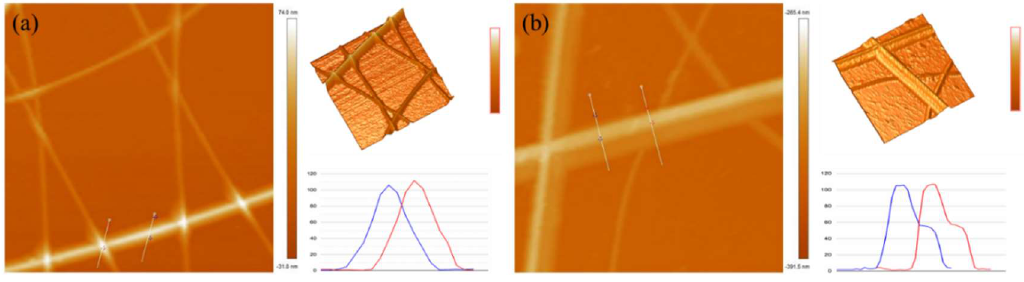
Figure 5. The atomic force microscope (AFM) images of ( a ) SLD‐AgNW films and ( b ) SLD‐AgNW/G films. The images at the upper right show the 3D AFM images, and the images at the bottom right show the height contrast between the line junctions and the line level.